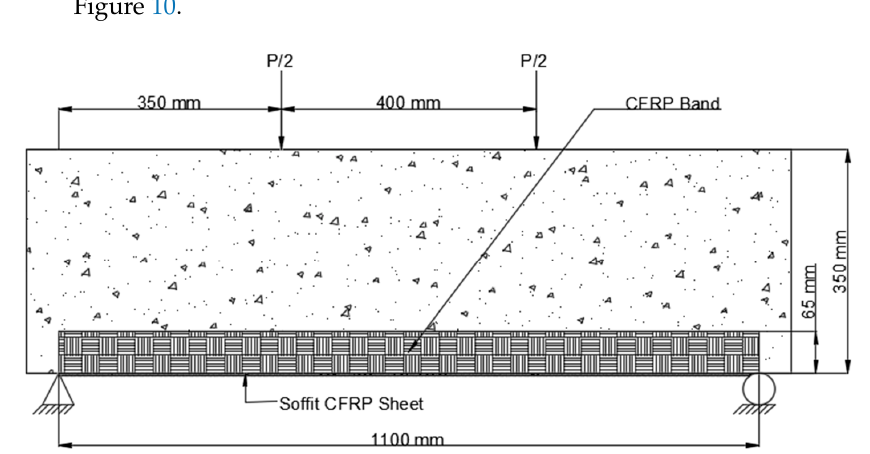
Figure 10. Placement of CFRP on beam Scheme 3 (B3). 4. Scheme 4 (B4) was similar to Scheme 2, with the exception that the CFRP sheet was enclosed across the side faces of the beam to a height of 150 mm above the tension face, as shown in Figure 11.